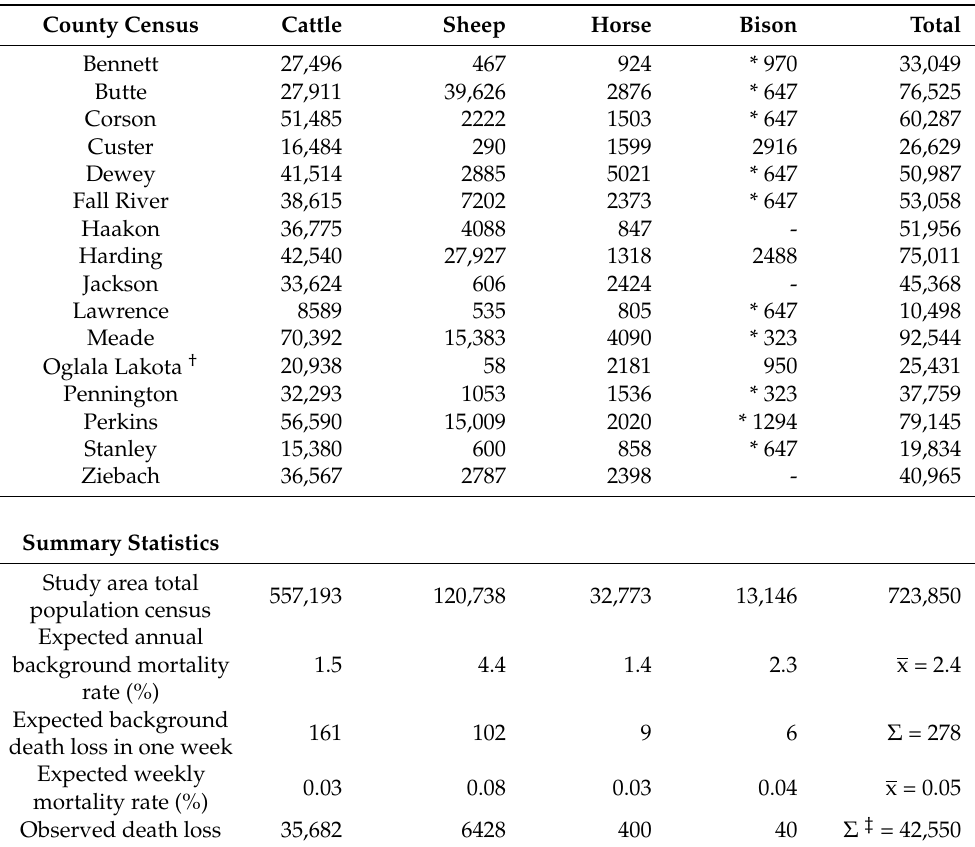
Table 1. Livestock population census by county and by study area total, expected annual background mortality rate, expected weekly death loss, expected weekly mortality, observed death loss, and observed mortality rate for beef cattle, sheep, horse, and bison in the study area of western South Dakota. Census data derived from USDA NASS [46]. Rounding may affect some summary statistics.